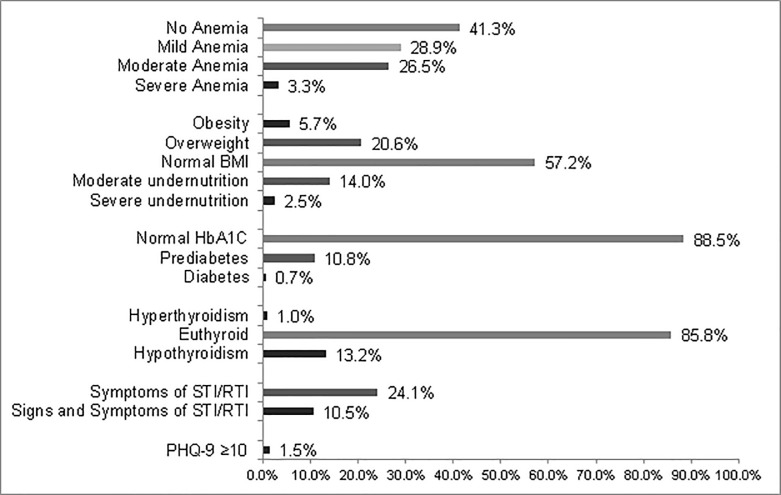
Prevalence of morbidity among nonpregnant married women aged 18 to 30 years residing in low- to middle-income urban communities in Delhi.Overall, 58.7% (95%CI: 56.5–60.9) of the women (1162/1979) had anemia, 16.5% (95%CI: 14.9–18.2) (330 women) were undernourished, and 26% (95%CI: 24.3–28.2) (525 women) were overweight or obese. In the 1979 women assessed, 13.2% (95%CI: 11.7–14.7) (261 women) were eligible for treatment with thyroxine. Prediabetes was detected in 10.8% (95%CI: 9.4–12.2) of participants, and only 0.7% (95%CI: 0.4–1.2) (14 women) had diabetes. Approximately one-tenth of the participants had both symptoms and signs of STIs/RTIs. In 29.9% (95%CI: 27.8–31.9) of the women, anemia was moderate to severe.